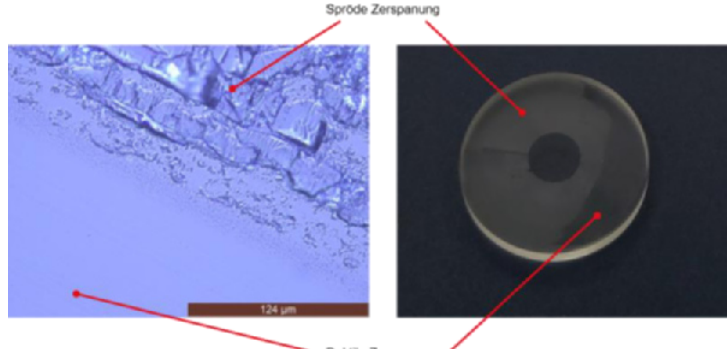
Figure 2: Brittle and ductile machining behavior of calcium fluoride (CaF2) and associated visual appearance of the machined surface (visible impairment of transmission in the region of brittle machining